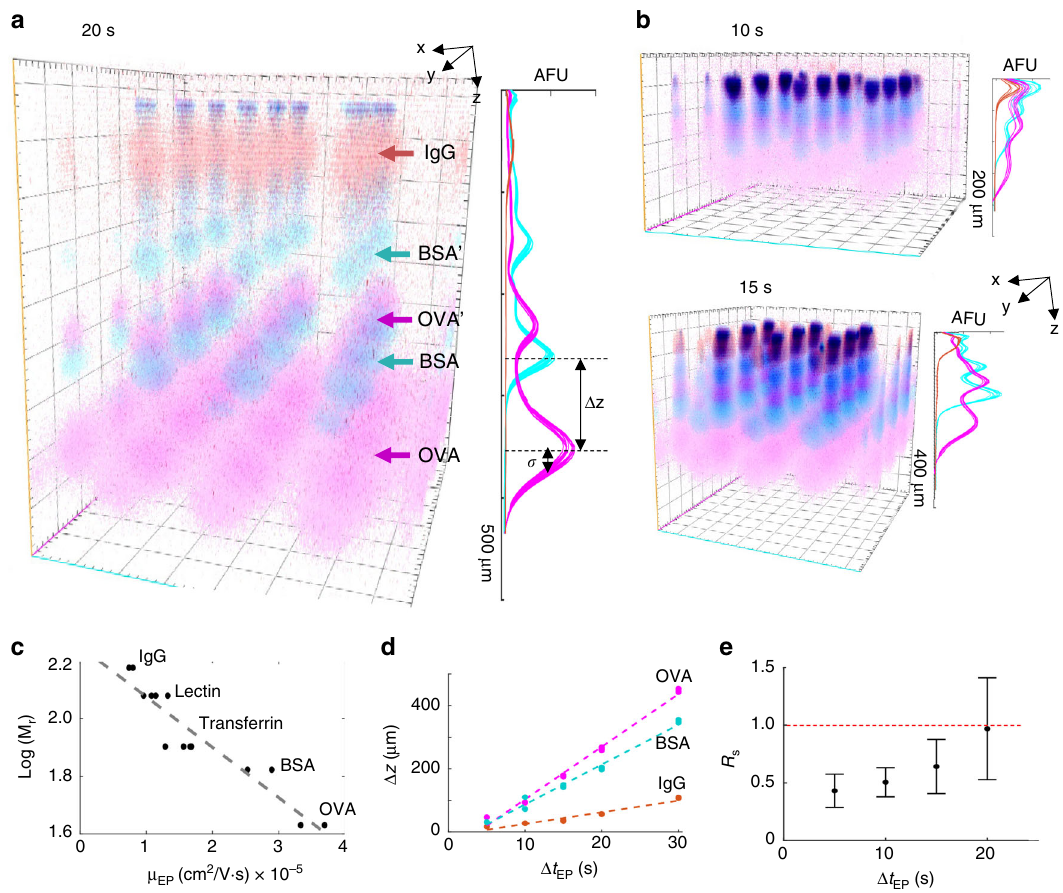
Fig. 2 Projection electrophoresis supports protein PAGE. ( a ) Confocal imaging of PAGE of fl uorescently labeled protein ladder at 20 s elapsed separation time. Each ladder sample is injected from a 32 μ m diameter microwell ( xy plane) with PAGE along the z -axis of the gel block. Summing the background- subtracted fl uorescence intensities at each pixel in the xy separation lane region of each slice image (a 300 pixel, 102 μ m square region centered on each microwell) yields a z -intensity pro fi le for each lane, with peak-to-peak displacement Δ z and peak width σ (10%T PA separation gel containing 10% Rhinohide ® ). ( b ) 3D renderings and z -intensity pro fi les are plotted for (i) 10 s electrophoresis and (ii) 15 s electrophoresis in 10%T PAGs containing 10% Rhinohide ® for comparison with the data for 20 s electrophoresis shown in ( a ). ( c ) The electrophoretic mobility of the proteins depends log-linearly on protein molecular mass. Each plotted point represents an electrophoretic mobility calculated from linearly fi tting migration distance vs. electrophoresis time data from 11 to 17 segmented separation lanes in n = 5 7%T PA separation gels containing 10% Rhinohide ® (5 electrophoresis times). Linear fi tting yields log(M r ) = 1.7 × 10 4 μ EP + 2.25 ( R 2 = 0.89). ( d ) Electromigration distance depends linearly on electrophoresis time, thus proteins migrate at constant velocity during PAGE. Migration distances are plotted from protein bands originating from 11 to 17 nearby microwells in two independent 7%T PA gels containing 10% Rhinohide ® ; 33 mA constant current; 52 V/cm initial, 2 gels for each migration time. Linear fi tting yields OVA migration = 16.7 t -63.42; BSA migration = 12.64 t -39.3; IgG migration = 3.69 t -11.54. ( e ) Separation resolution, R s , for BSA and OVA peaks in 10%T PAGE gels containing 10% Rhinohide ® . Each point depicts the mean and standard deviation of the R s calculation from the median migration distances and peak widths from n = 4 independent separation gels. Source data are provided as a Source Data fi